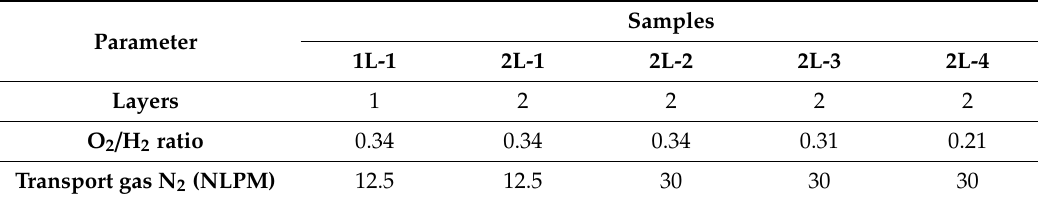
Table 1. Spraying parameters used in the high velocity oxygen-fuel (HVOF) process.